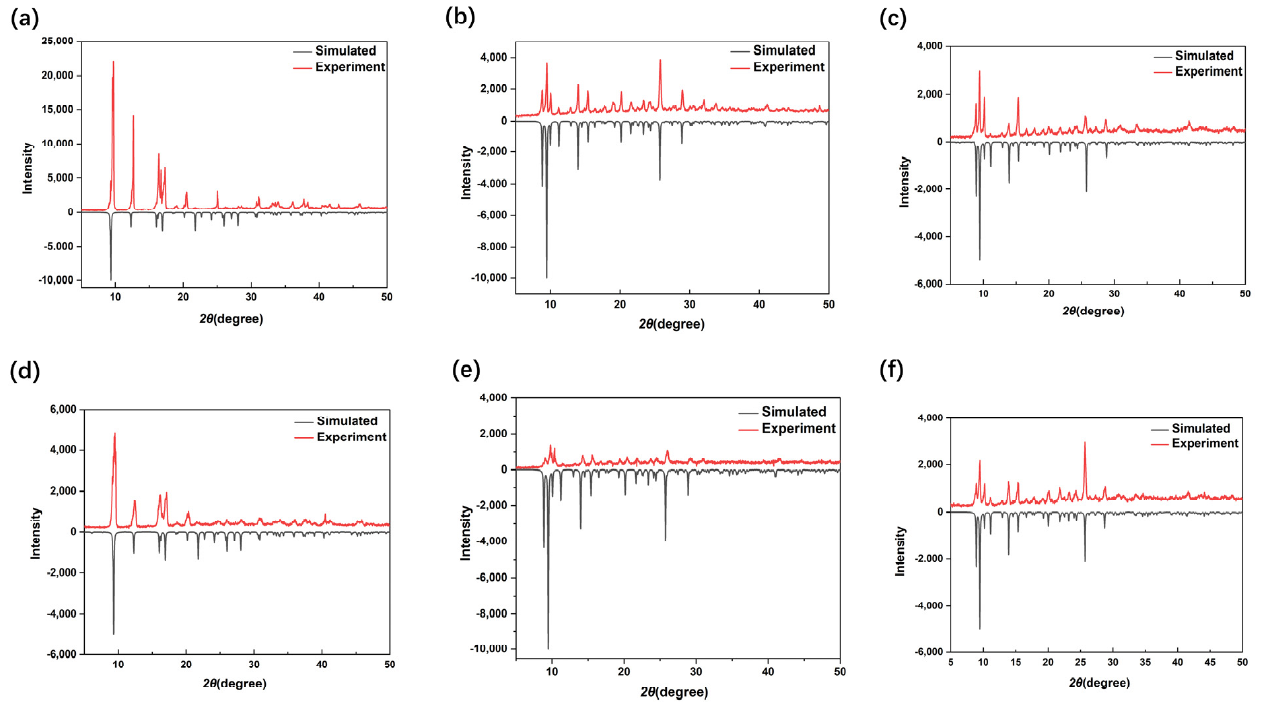
Figure 4. PXRD spectra of 1- S ( a ), 1- R ( d ), 2- S ( b ), 2- R ( e ), 3- S ( c ) and 3- R ( f ).